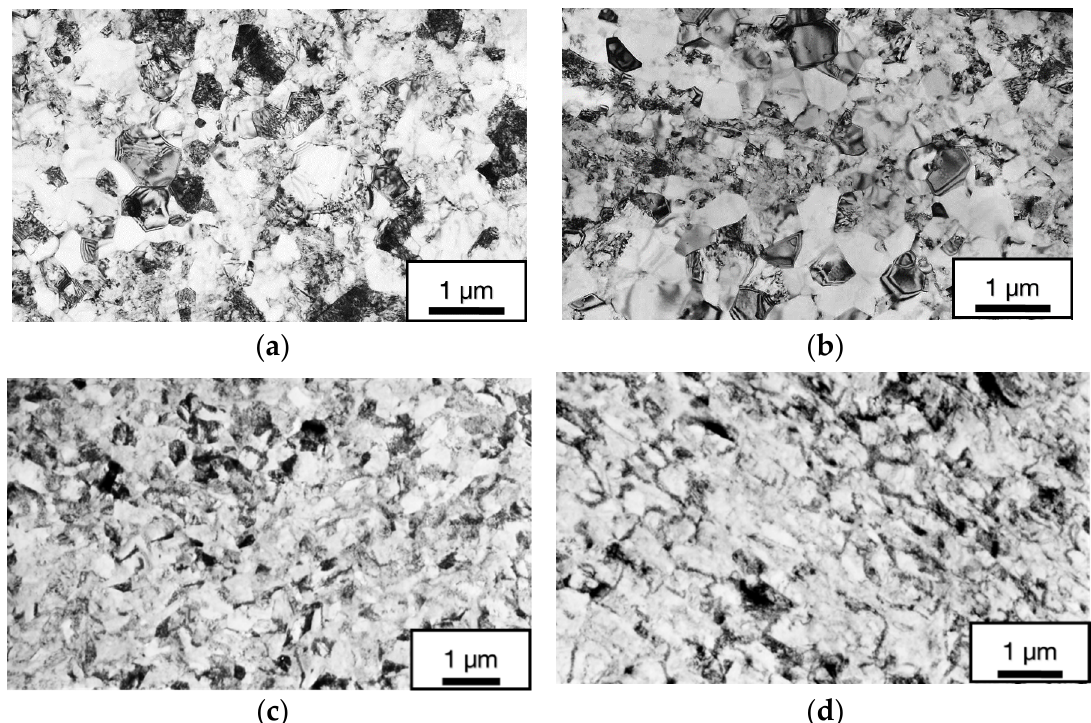
Figure 11. TEM micrographs of mechanically-worked titanium Grade 4: ( a ) after one Conform SPD pass, longitudinal cross-section, ( b ) after one Conform SPD pass, transverse cross-section, ( c ) after one Conform SPD pass and rotary swaging (1.6 true strain—80% area reduction), longitudinal cross-section, ( d ) after one Conform SPD pass and rotary swaging (1.6 true strain—80% area reduction), transverse cross-section. Table 2. Subgrain sizes in the materials as estimated from TEM micrographs.